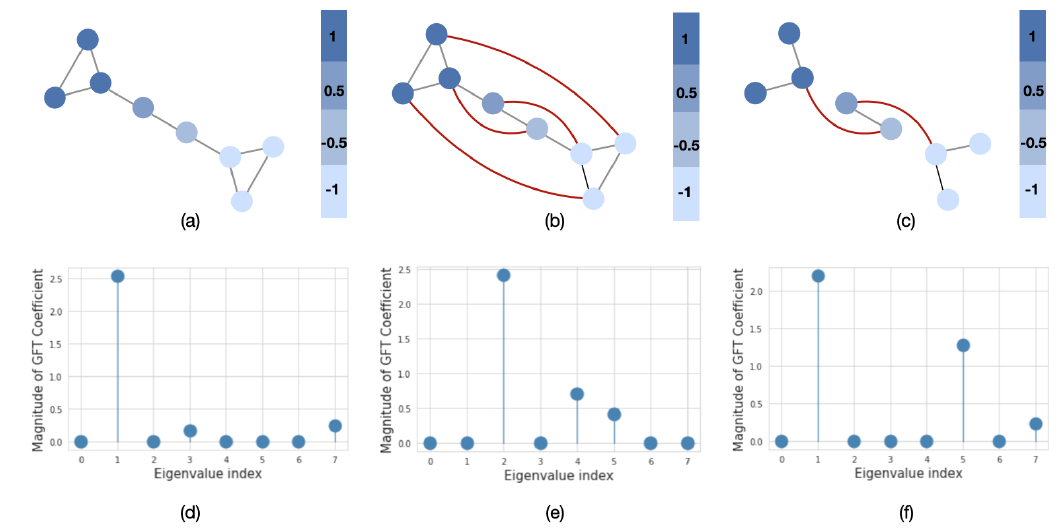
Figure 3. The importance of the graph structure. We plot the graph signal in the node (upper row) and spectral (lower row) domains. The red lines in ( b ) and ( c ) represent the addition of new edges to the original graph in ( a ). The eigenvalues in ( d – f ) are sorted in order of the increasing